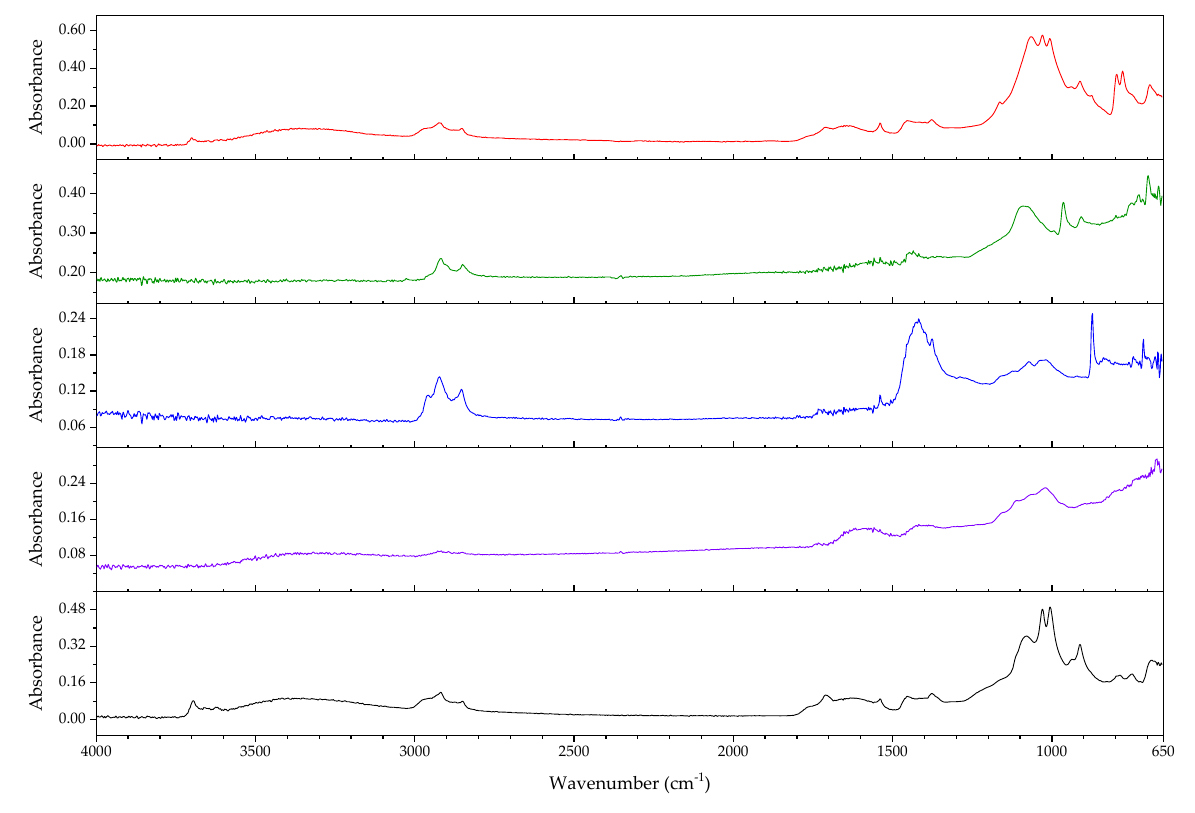
Figure 2. FTIR spectra of the samples detailed in Table 9. From top to bottom: 194, 383, 431, 530 and 598.